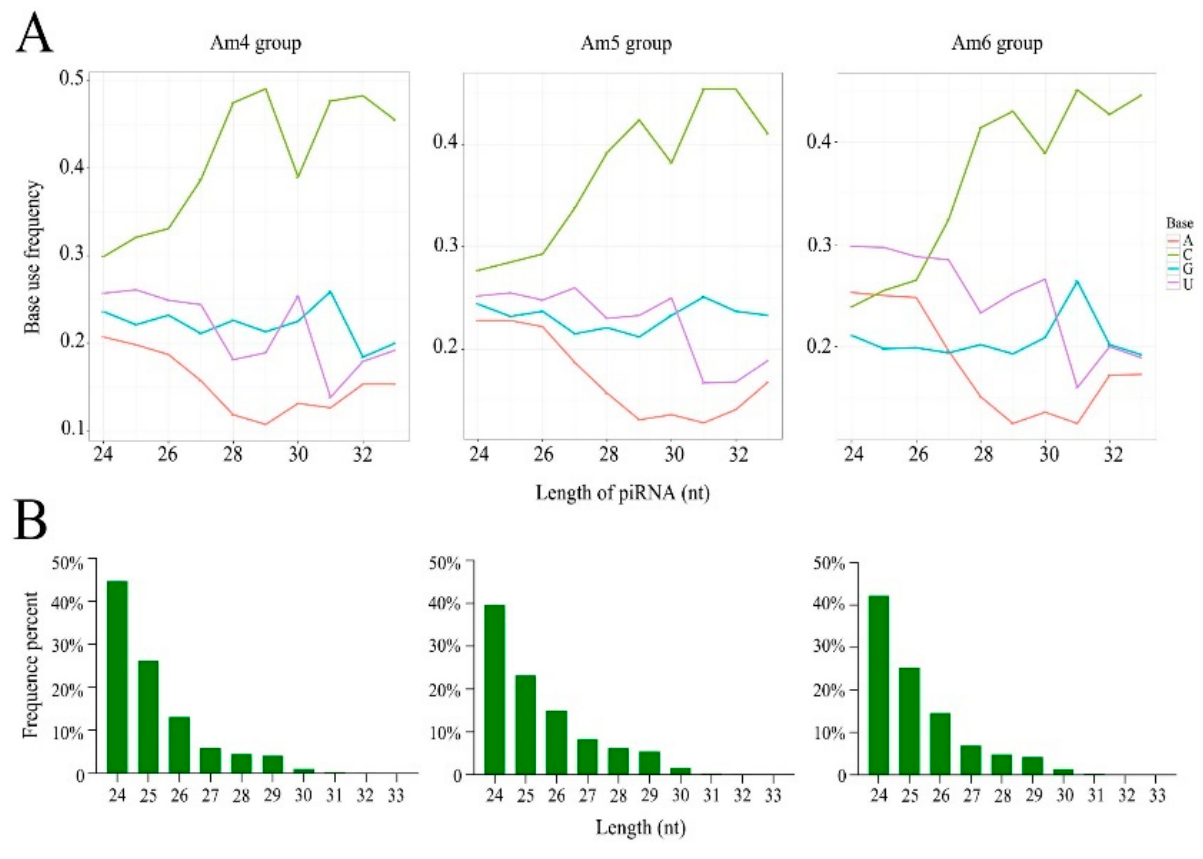
Figure 1. First base bias ( A ) and length distribution ( B ) of piRNAs that were identified in Am4, Am5, and Am6 groups.